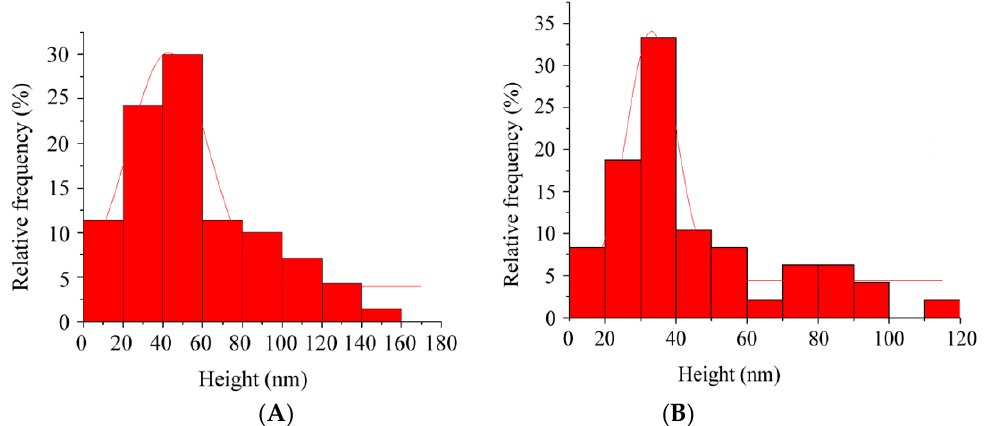
Figure 4. Particle size and size distribution according to AFM analysis of ( A ) Blank and ( B ) RFB-loaded NLC. Results were adjusted to a gaussian distribution.